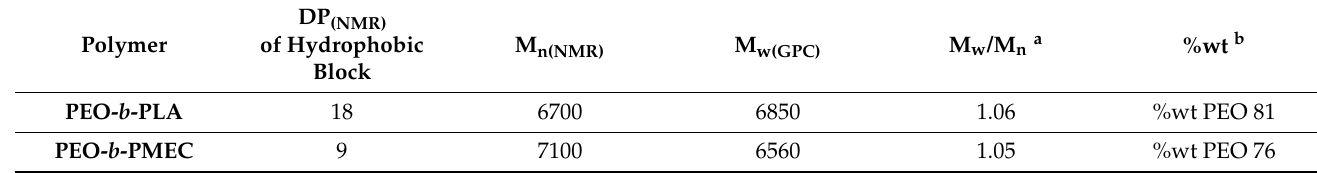
Table 1. Molecular characteristics of copolymers